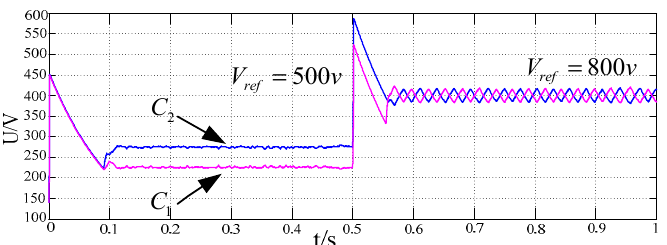
Figure 12. Change in the reference voltage value.